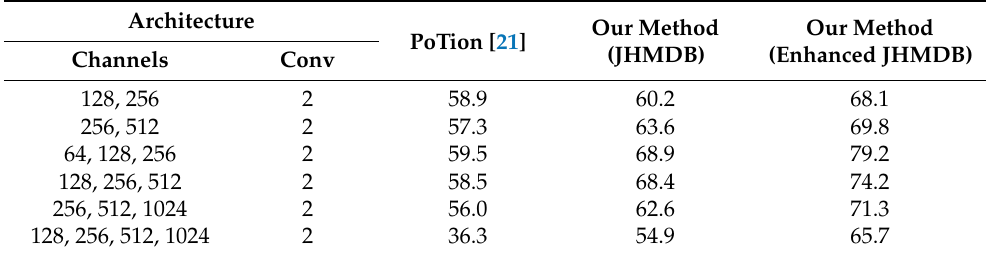
Table 1. Comparison of the recognition accuracy with PoTion under different convolutional layer models.